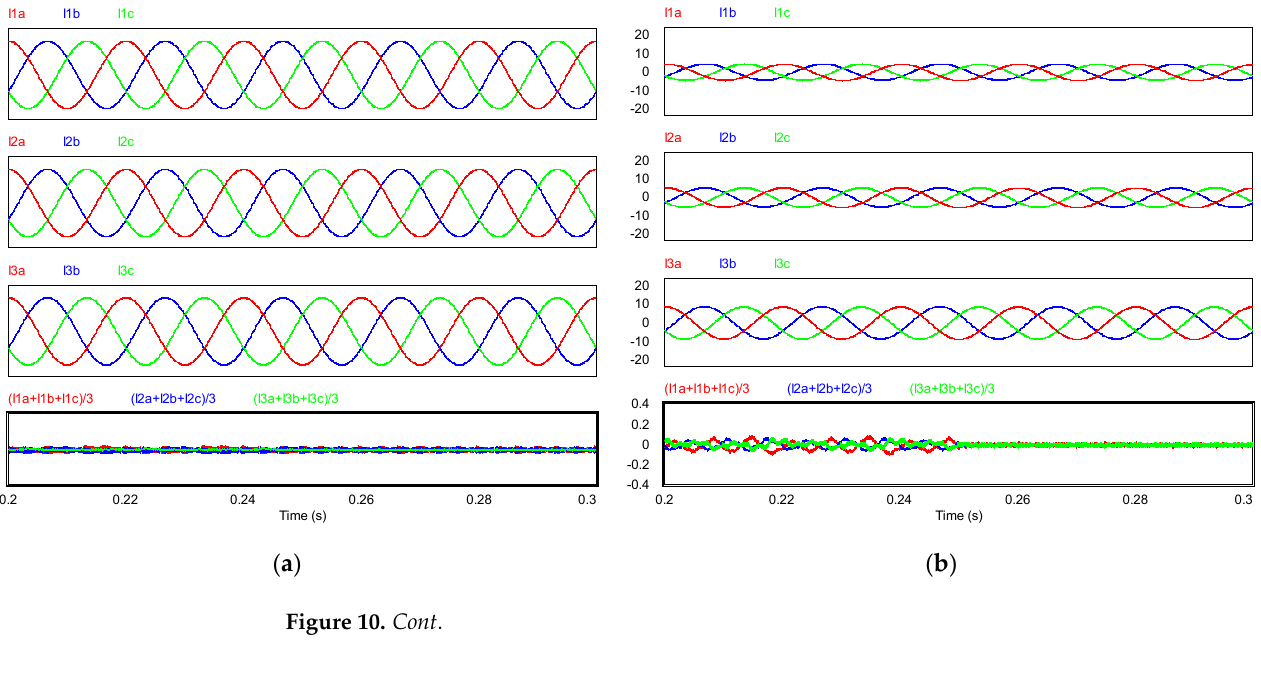
Figure 9. Simulation results of the control of the circulating currents of two inverters connected in parallel ( a ) with unbalanced inductances in both inverters, ( b ) with unbalanced load factor between inverters, ( c ) with unbalanced inductances in the same inverter, ( d ) with a different modulation in each inverter.